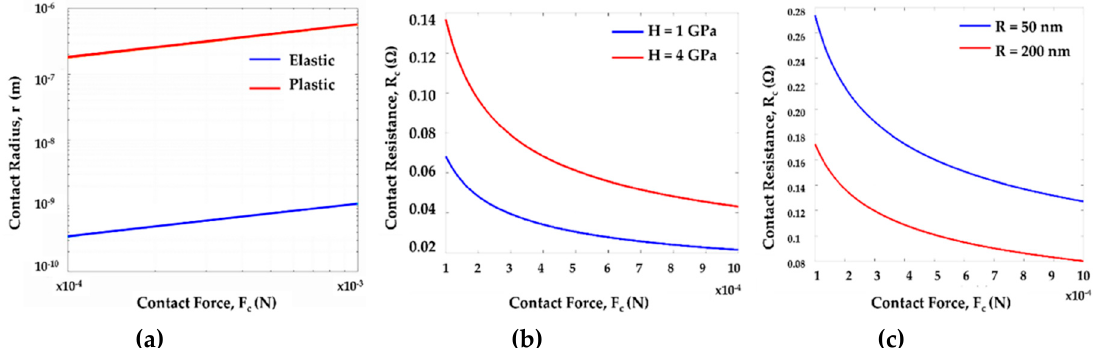
Figure 20. ( a ) Contact radius of a single gold (Au) asperity for elastic and plastic region; ( b ) contact resistance with varied hardness for a gold (Au) “a-spots”; ( c ) contact resistance of a single gold (Au) asperity contact with varied radius of curvature.